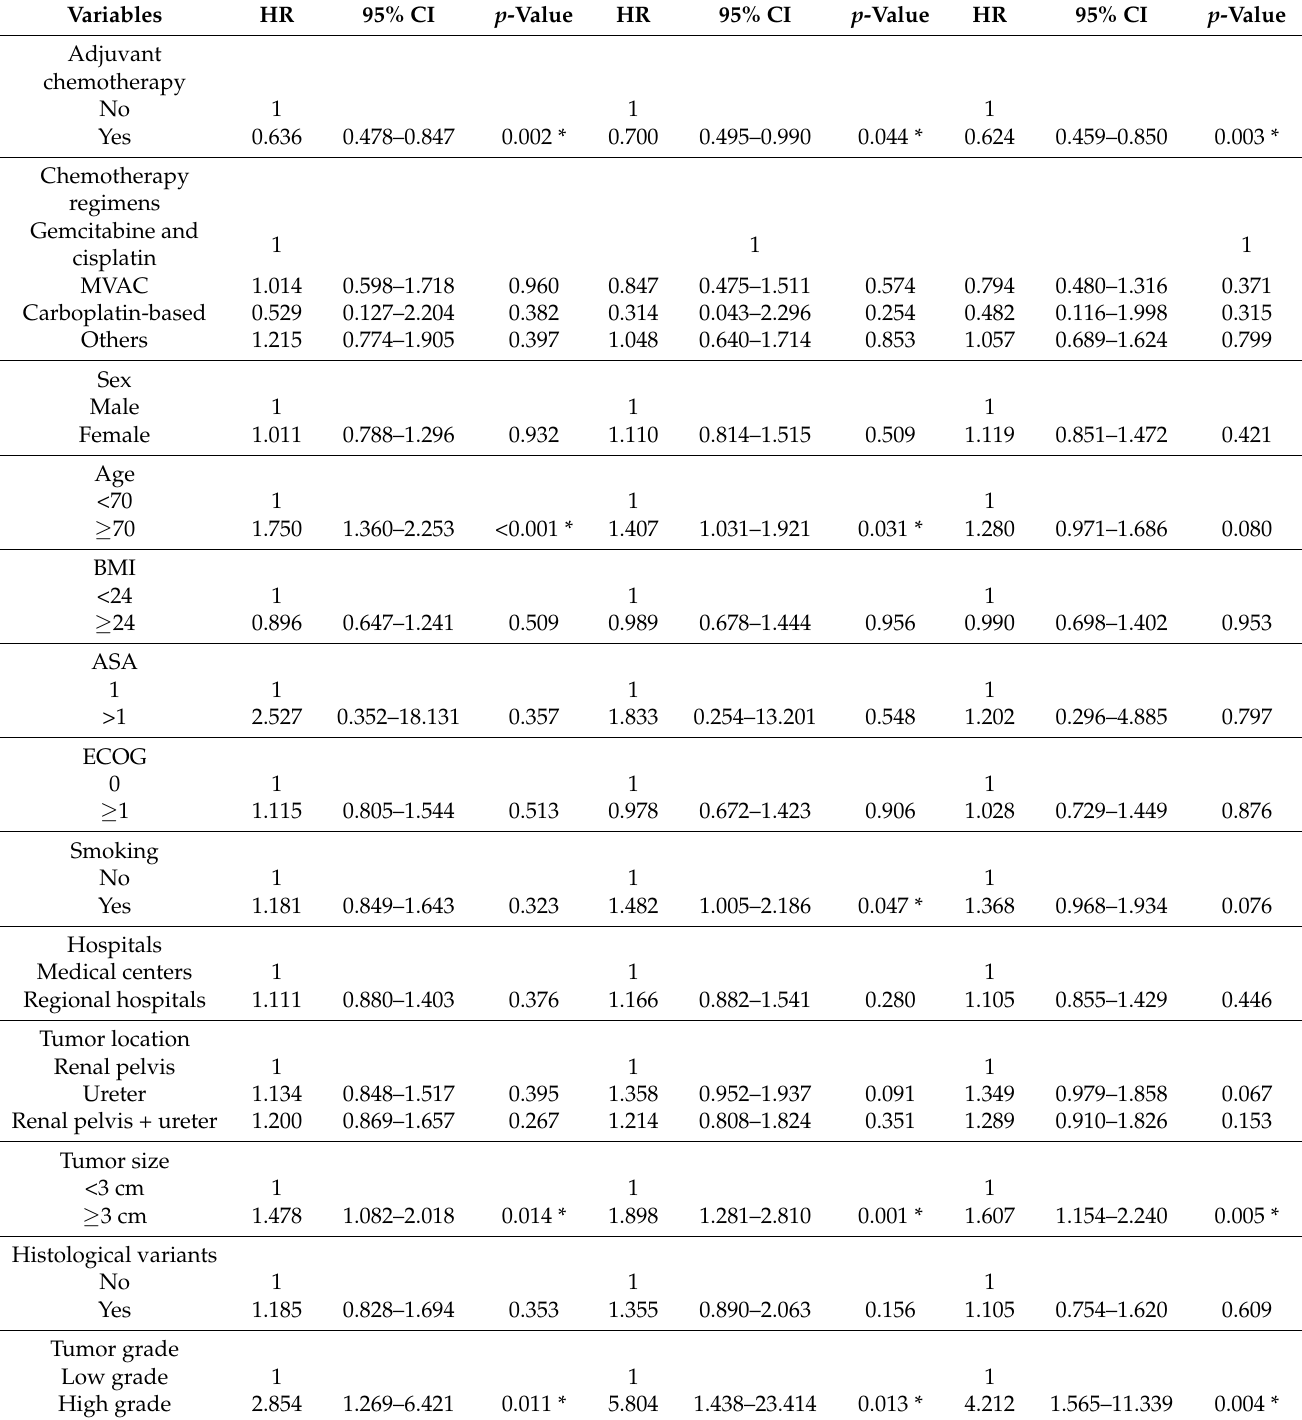
Table 2. Univariate analyses for overall, cancer-specific, and disease-free survivals in advanced UTUC patients. Overall Survival Cancer-Specific Survival Disease-Free